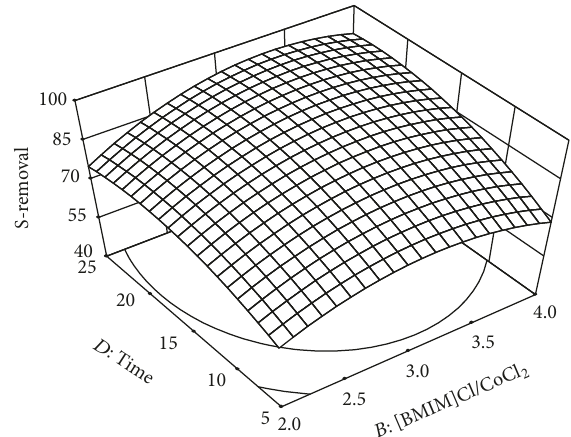
Figure 5: The response surface plot about effect of [BMIM]Cl/ CoCl 2 dosage and time interaction on S-removal.